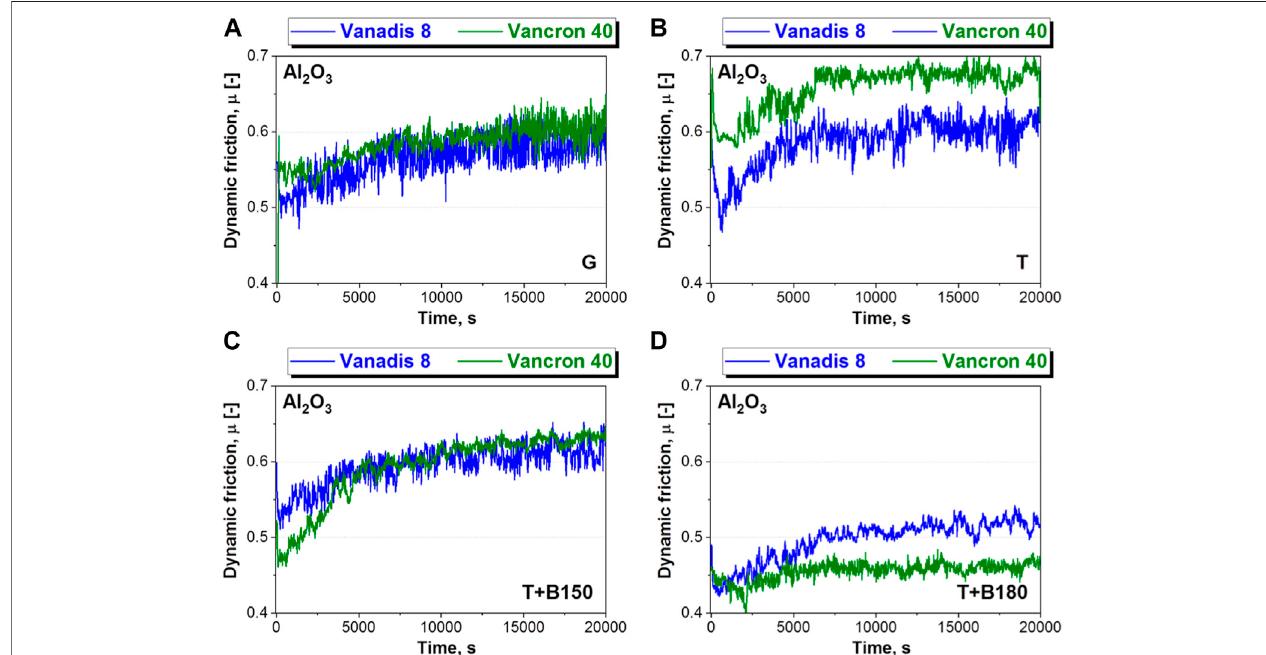
FIGURE9| Dynamicfrictioncoef fi cientsforVanadis8andVancron40samples,followingthemechanicalprocessesofSLmodi fi cations: (A) G, (B) T, (C) T+B150, (D) T + B180. Ball-on-disc tests carried out against Al 2 O 3 pins.